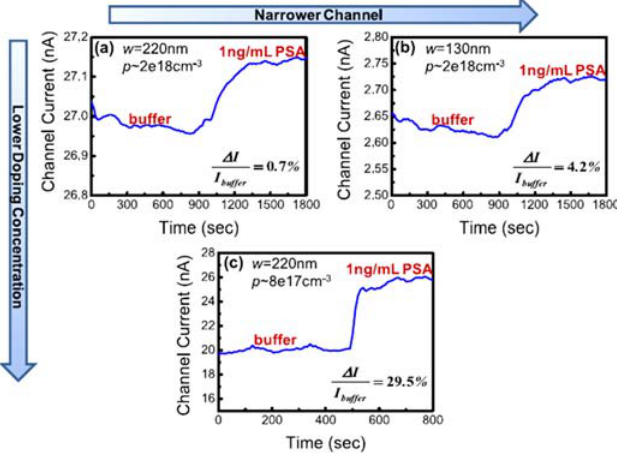
Figure 6. Demonstration of the effects of the SVR and doping concentration on the overall sensitivity for the real-time detection of the prostate serum antigen (PSA) biomarker (1 ng mL − 1 ): ( a ) SiNW width = 220 nm and doping concentration ∼ 2 × 10 18 cm − 3 ; ( b ) SiNW width = 130 nm and doping concentration ∼ 2 × 10 18 cm − 3 ; and ( c ) SiNW width = 220 nm and doping concentration ∼ 8 × 10 17 cm − 3 . Reprinted with permission from Ref. [120], Copyright (2009),